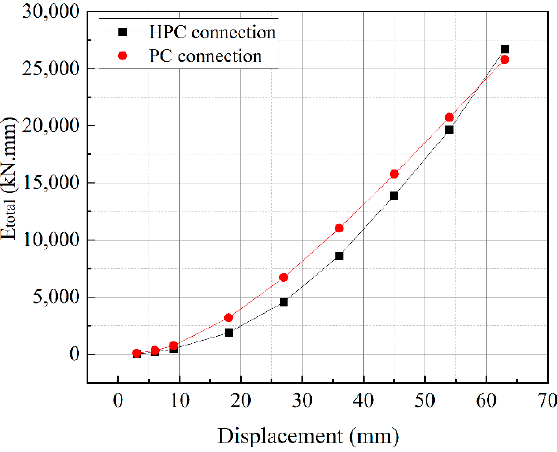
Figure 13. Energy dissipation with displacement.